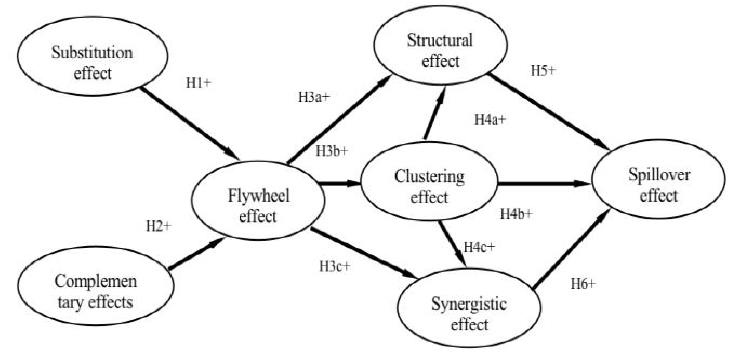
Figure 2. Effects of the digital economy on agricultural labor employment and their relationships (in terms of the model hypothesis).